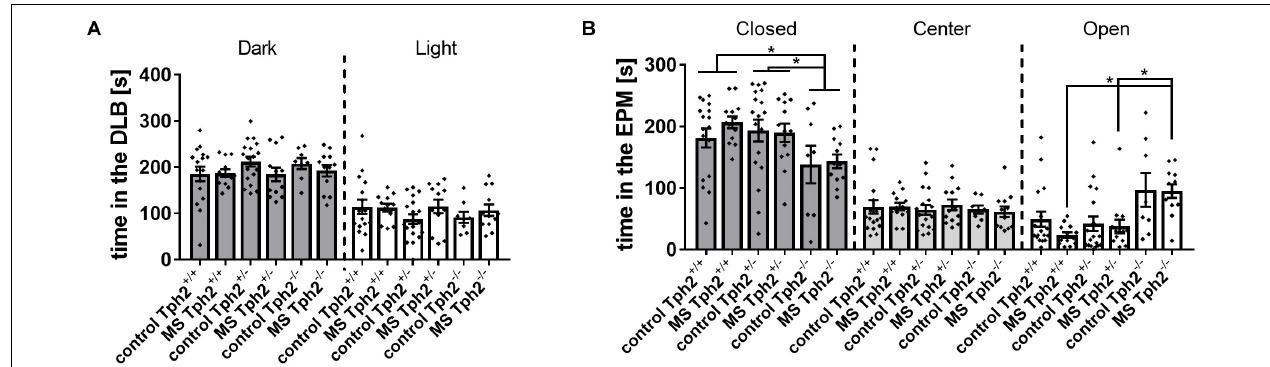
FIGURE 1 | Anxiety-related behaviors in (A) the dark-light box (DLB) and (B) the elevated plus-maze (EPM): DLB performance was unaffected by both tryptophan hydroxylase 2 (Tph2) genotype and maternal separation (MS). In the EPM, full TPH2 inactivation increased the time [s] spent on open arms in offspring exposed to MS and decreased the time spent in closed arms, independent of MS. Bars represent group means ± standard errors ( n /group = 8–18). ∗ FDR corrected p < 0.050 ( Post hoc : Mann-Whitney U).